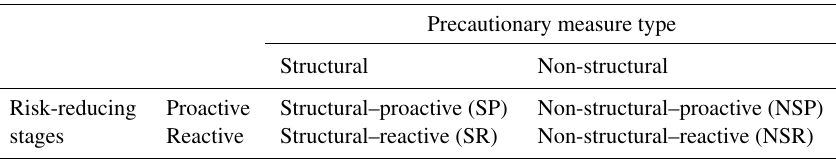
Table 2. Household groups classified based on the type of implemented precautionary measure (structural and non-structural measures) and risk-reducing stages (proactive and